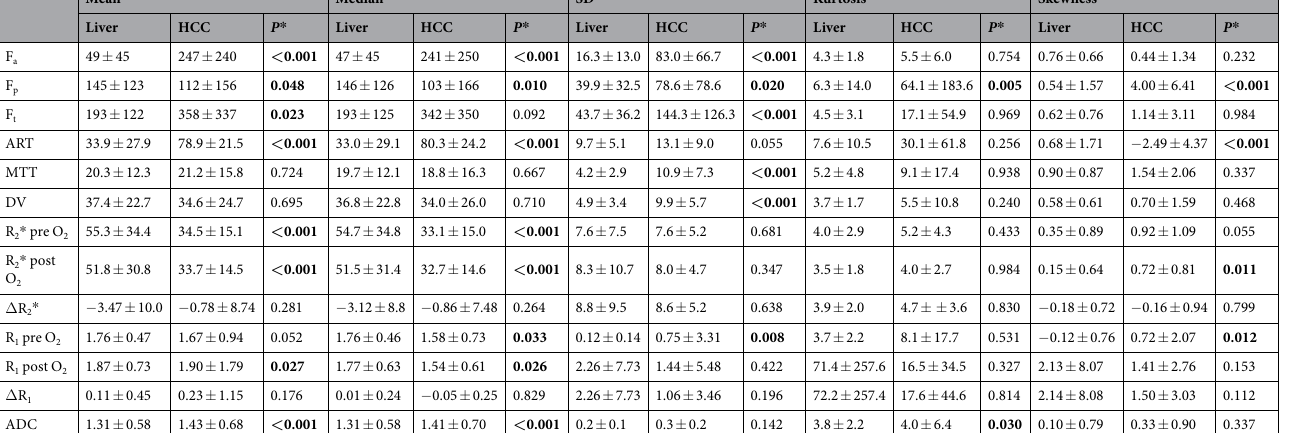
Table 2. Central tendency (mean and median) and heterogeneity (SD, kurtosis, skewness) MRI parameters in 39 HCC lesions and liver parenchyma in 32 patients. * P -values from Wilcoxon signed rank tests. Significant P -values are bolded. ADC = apparent diffusion coefficient (10 − 3 mm 2 /s), ART = arterial fraction (%), DV = distribution volume (%), F a = arterial flow (ml/100 g/min), F p = portal flow (ml/100 g/min), F t = total flow (ml/100 g/min), MTT = mean transit time (s), R 1 = longitudinal relaxation rate (s − 1 ), R 2 * = transverse relaxation rate (s − 1